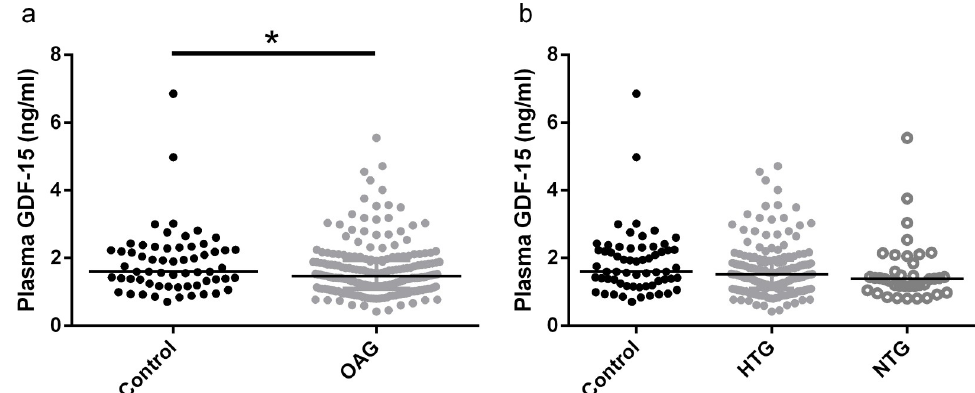
1.95) and NTG: 1.38 ng/ml (1.14–1.90). OAG: Open-angle glaucoma; HTG: High tension glaucoma; NTG: Normal tension glaucoma.